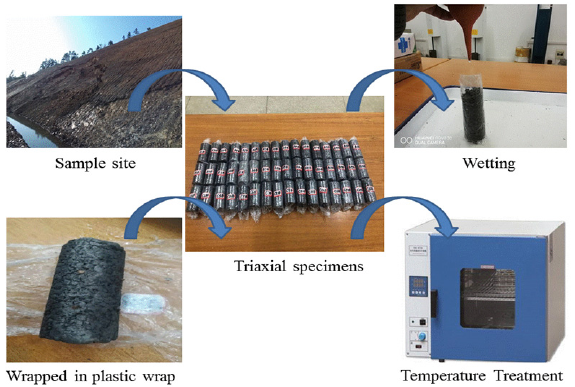
Figure 3. Preparation procedure of C-M-S